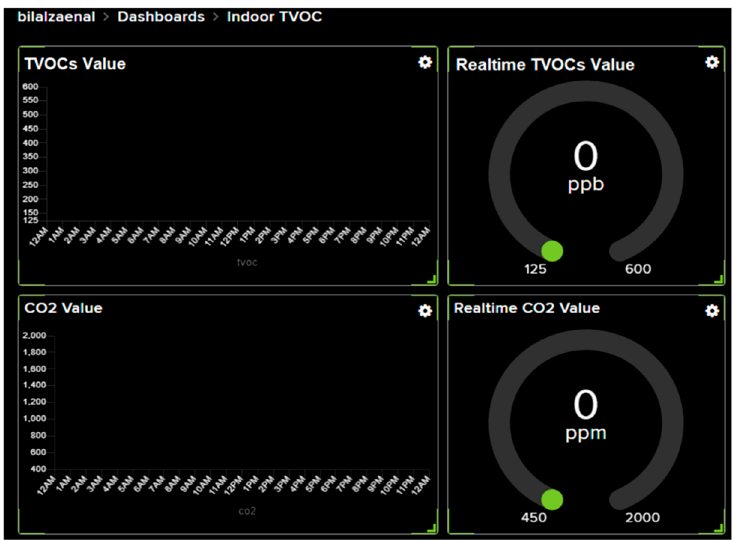
Figure 13. Dashboard design.